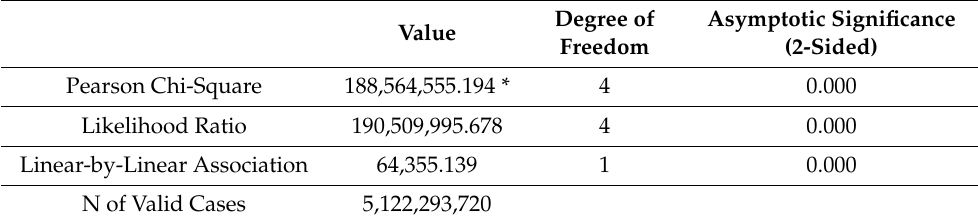
Table 8. Chi-square tests for different models.